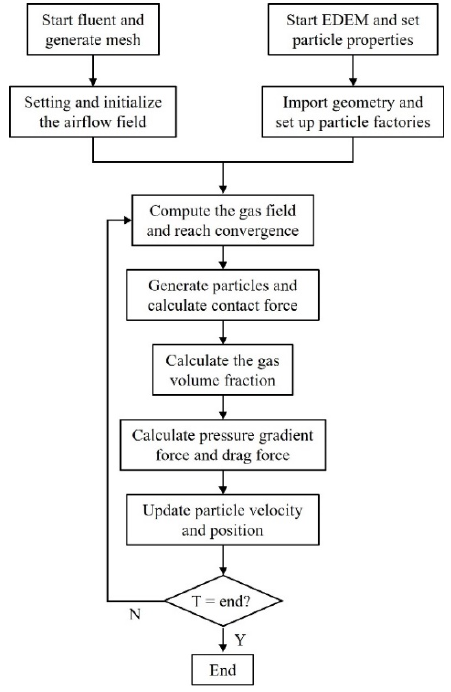
Figure 4. Flowchart of gas–solid coupling simulation. Table 1. Computational parameters used in the